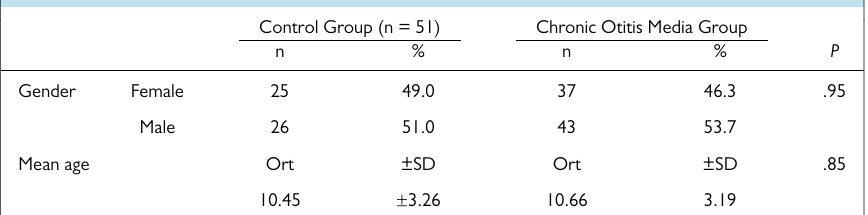
Table1. Gender and Age of the Groups Control Group (n = 51) Chronic Otitis Media Group n